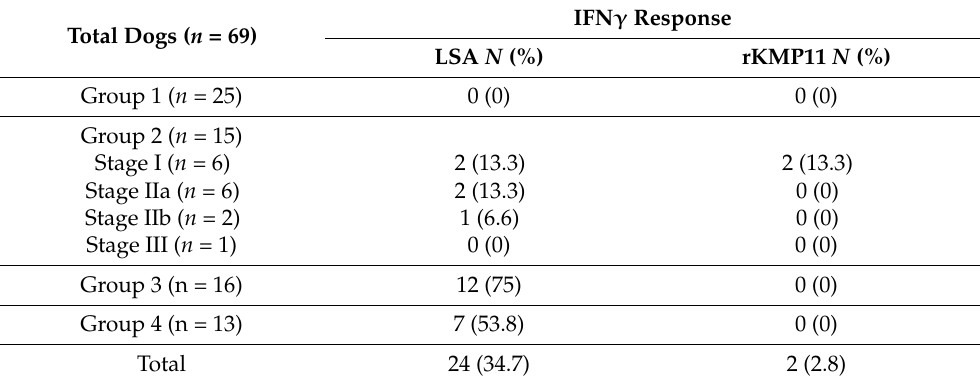
Table 2. Positive results to specific ex vivo IFN- γ response to L. infantum and rKMP11 in apparently healthy non-infected dog from Asturias, Spain, a low endemicity area (Group 1), sick dogs from Catalonia (Spain) (Group 2), apparently healthy Ibizan hound dogs from the high endemicity area of Mallorca (Spain) (Group 3) and apparently healthy dogs from the high endemicity area of Bari (Italy) (Group